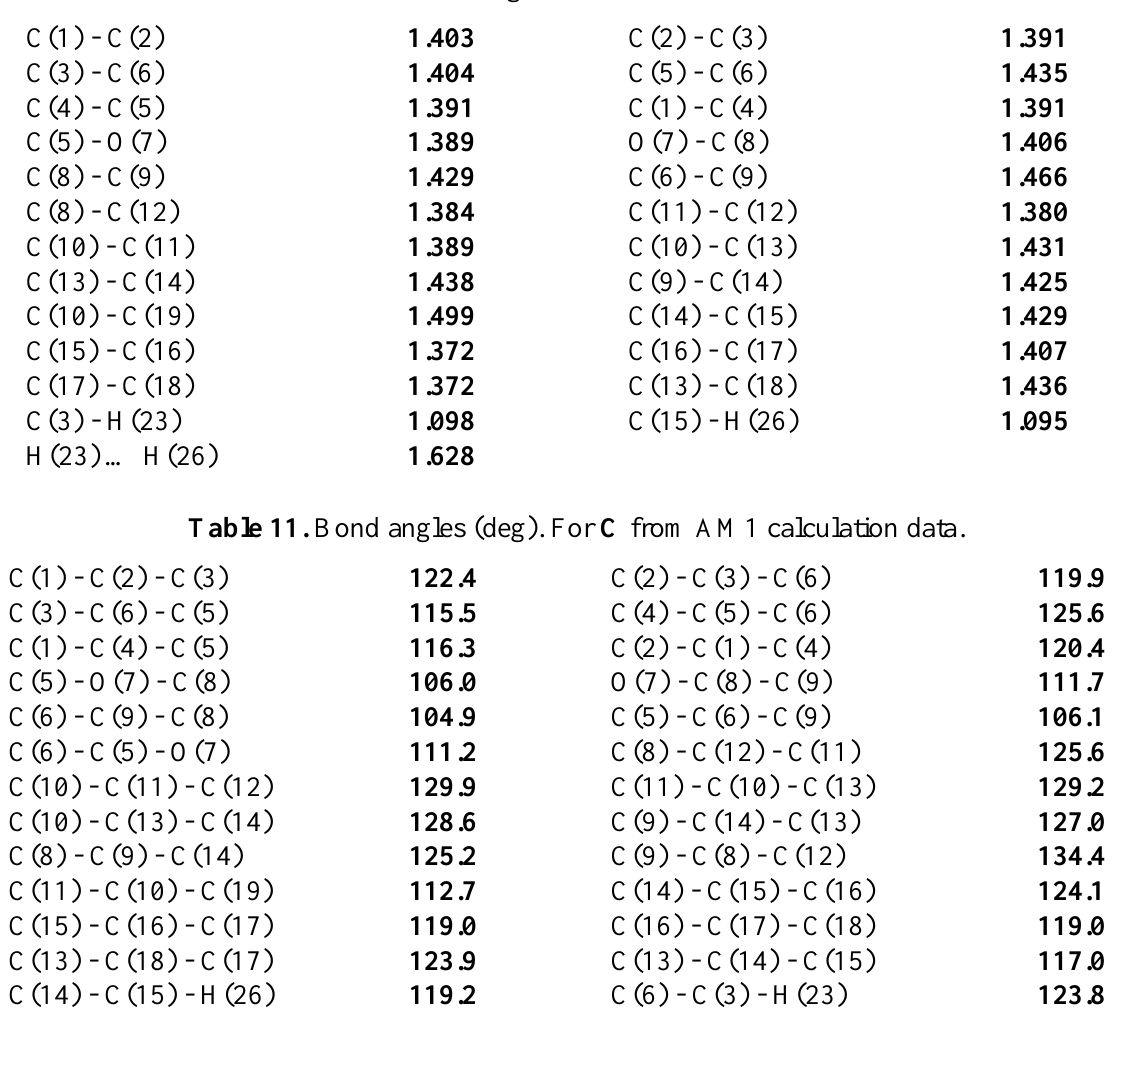
Table 10. Bond lengths (A) for C from AM1 data.